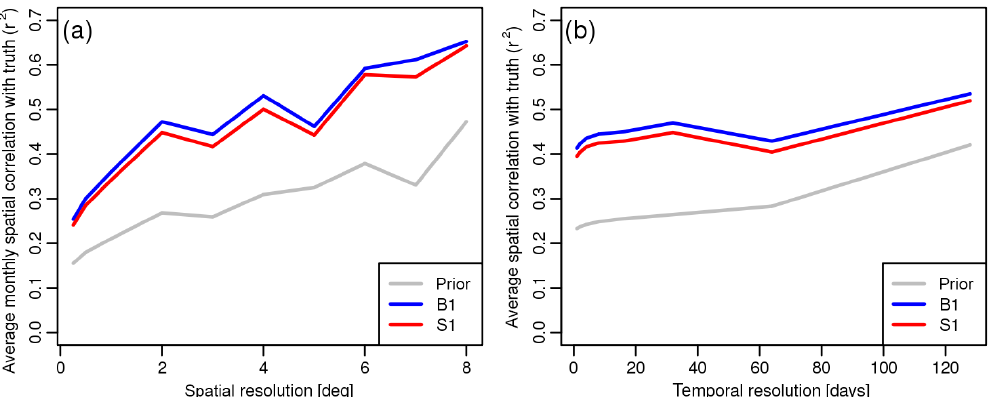
Figure 11. (a) Mean spatial correlation of monthly fluxes with true fluxes as functions of the spatial flux aggregation scale for prior fluxes (grey) and for posterior fluxes from scenarios B1 (blue) and S1 (red). (b) Mean spatial correlation of fluxes with true fluxes at 2 ◦ spatial resolution as functions of temporal flux aggregation scale for prior fluxes (grey) and for posterior fluxes from scenarios B1 (blue) and S1